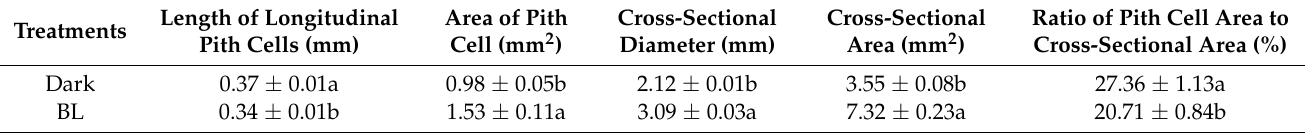
Table 2. Parameters related to anatomical structure of soybean hypocotyls under blue light.